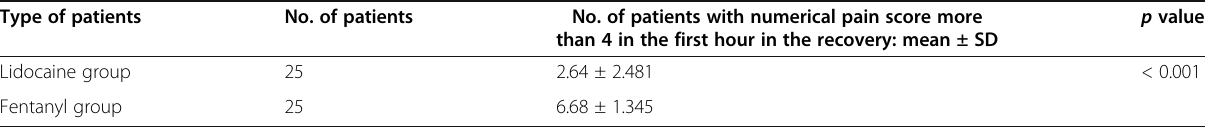
Table 4 Numerical pain score in the recovery Type of patients No. of patients